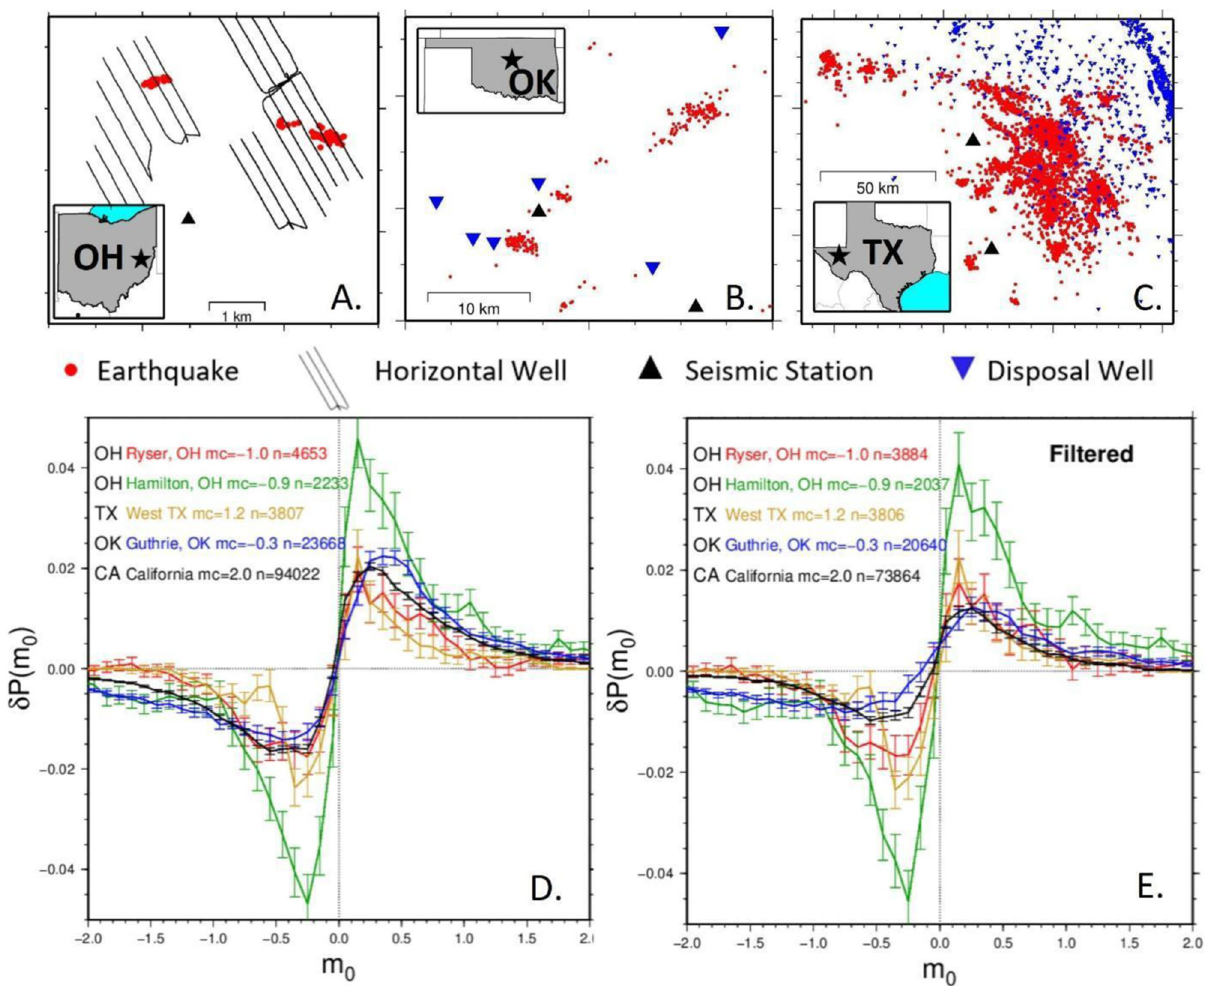
(cid:1) (cid:3) , as a